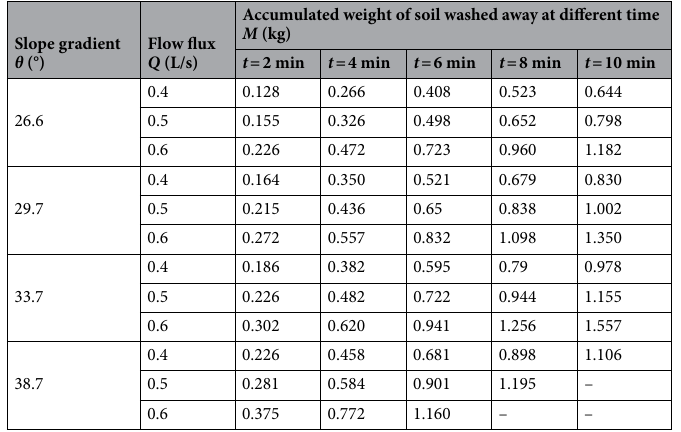
Table 2. Accumulated weight of soil washed away at t = 2, 4, 6, 8 and 10